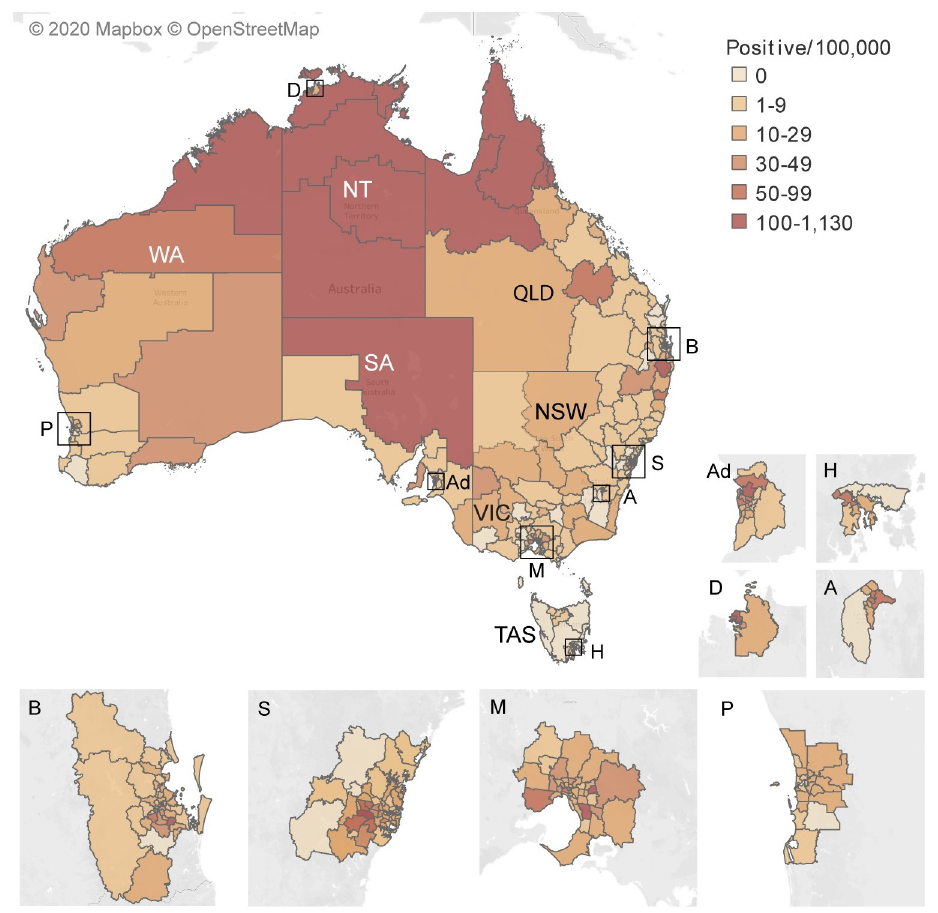
Fig 2. Strongyloides serology: map 1 showing the number of people positive per 100,000 population, for each ABS statistical area level 3 (region), 2012–2016, Australia and greater capital cities, including the positive data from all six laboratories. 1 This map was created using, our data, Tableau software, an ABS shapefile and a Mapbox base map. A = ACT; Ad = Adelaide; B = Brisbane; D = Darwin; H = Hobart; M = Melbourne P = Perth; S = Sydney; NSW = New South Wales; NT = Northern Territory; QLD = Queensland; SA = South Australia; TAS = Tasmania; VIC = Victoria; WA = Western Australia.